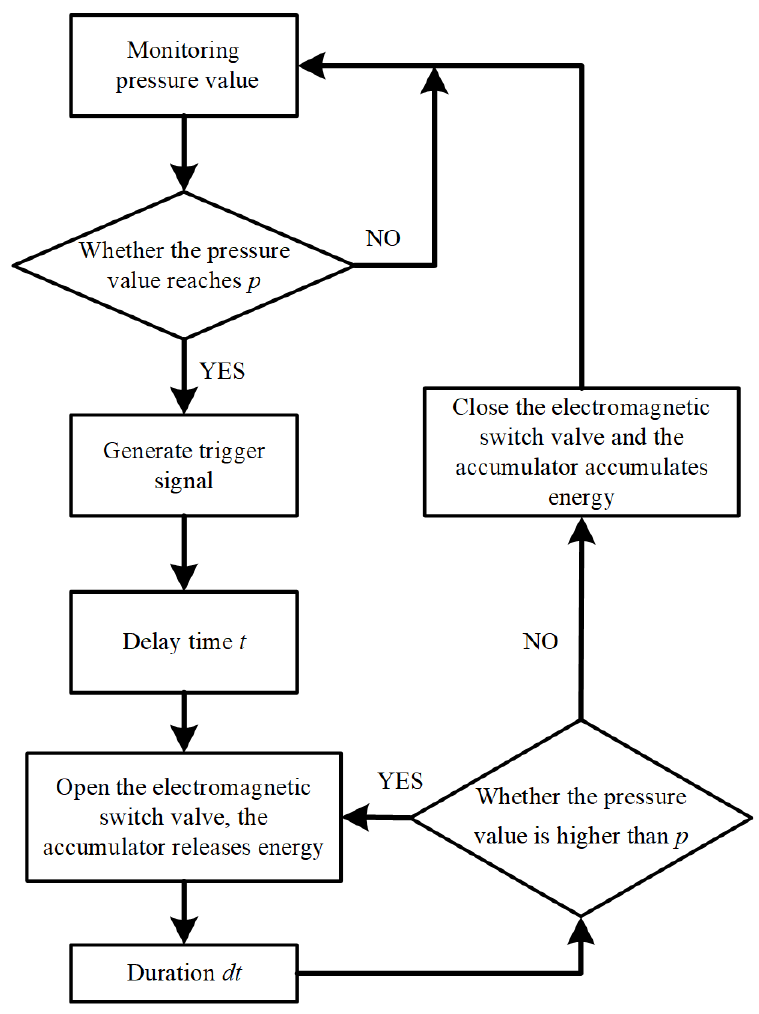
Figure 6. Control logic block diagram of hydraulic accumulator.